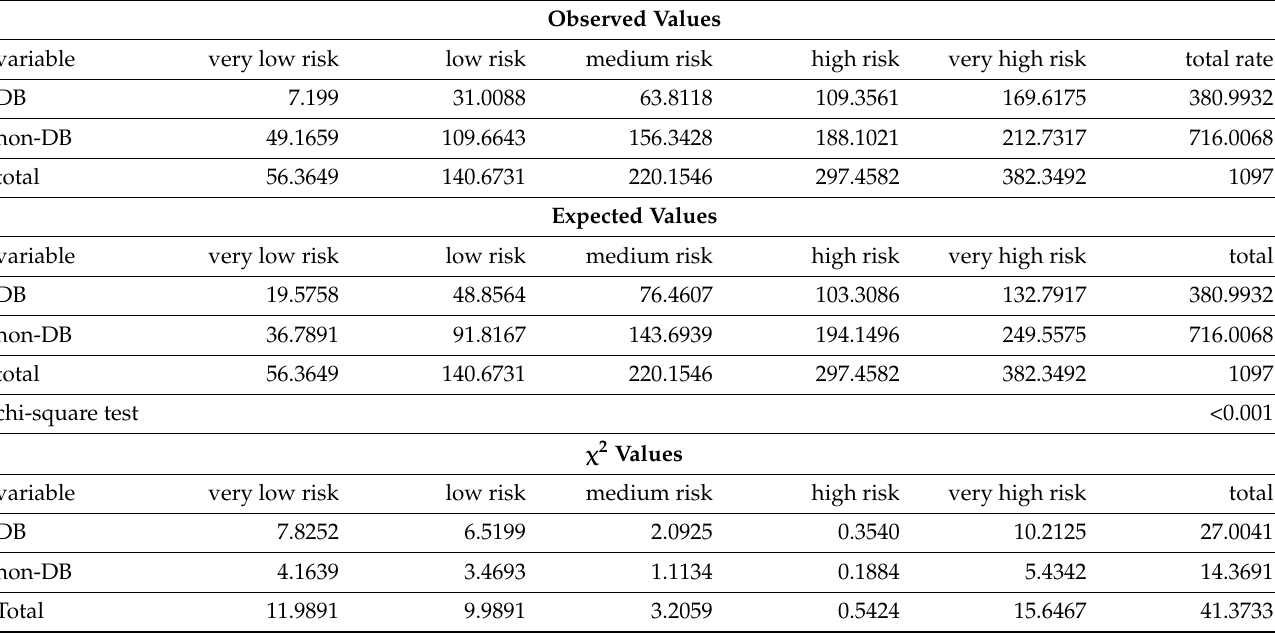
Table 2. Process of the Chi-square analysis. Observed Values